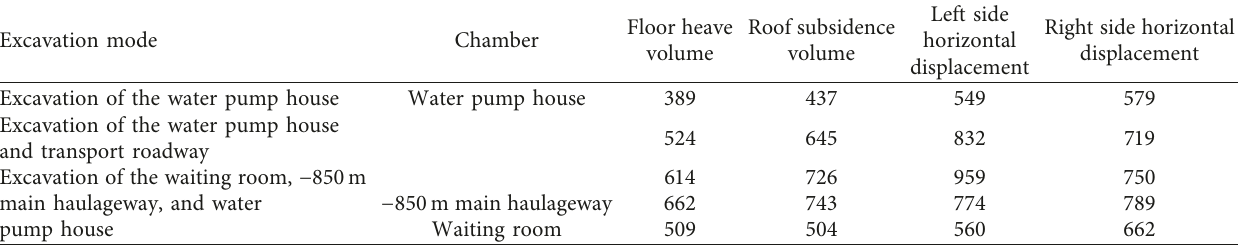
Table 3: Deformation of the chamber under different excavation modes (unit: